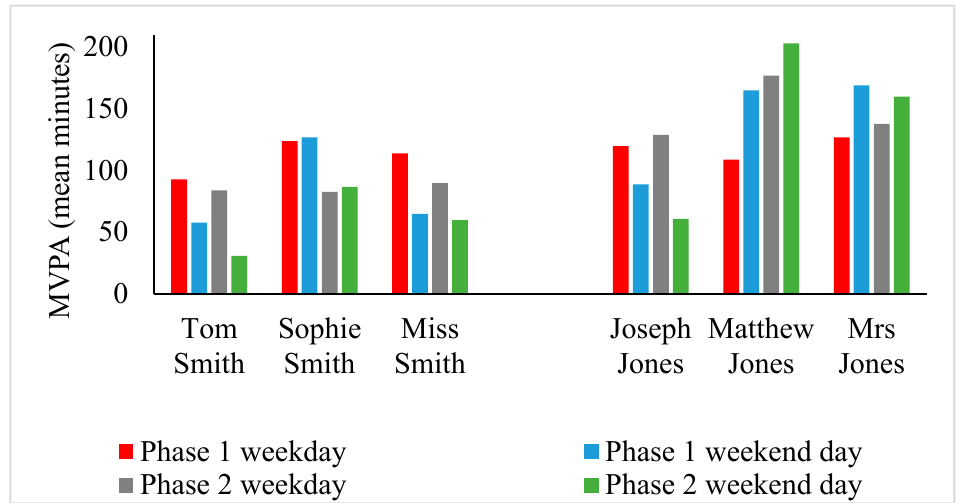
Figure 1. Mean weekday and weekend-day moderate-to-vigorous physical activity (MVPA) family Figure 1 . Mean weekday and weekend ‐ day moderate ‐ to ‐ vigorous physical activity (MVPA) family comparisons for each participant and comparisons for each participant and phase.